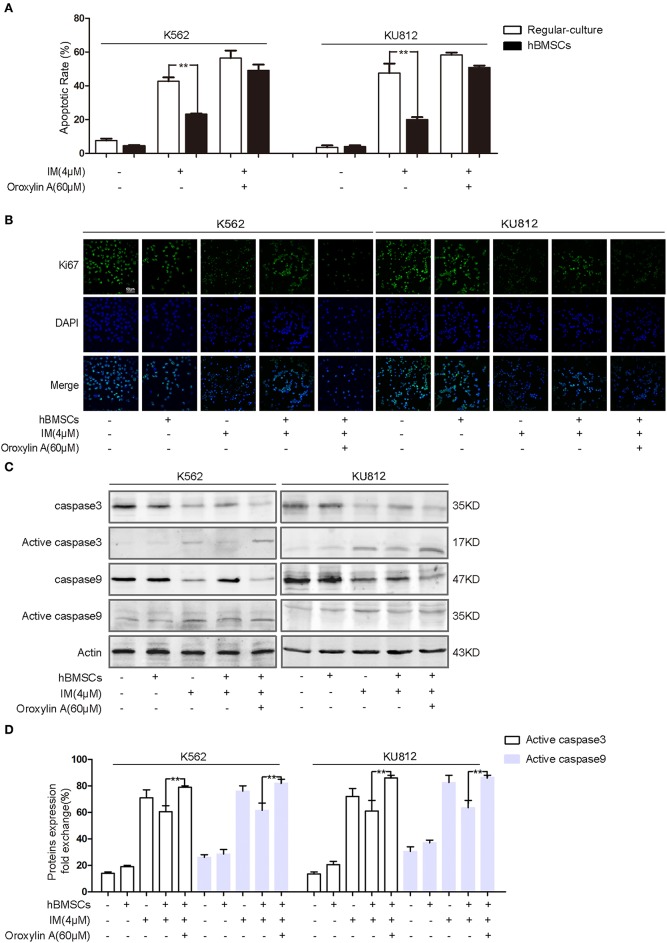
Oroxylin A reversed the effect of protection of BMSCs on CML cells. K562 and KU812 cells were cultured with or without IM and Oroxylin A in normal group or co-culture group for 48 h. Cell proliferation was determined by Annexin V-PI double-staining assay and Ki67 cell proliferation detection. (A) Percentage of apoptosis in K562 and KU812 cells after treatment. (B) Ki67 cell proliferation detection. (C) The expression of cleaved-caspase3 and 9 was determined using western blot analysis. (D) Analysis of proteins expression. Data (A) and (D) were shown as Means Å SD for three independent experiments. (*p < 0.05 and **p < 0.01).